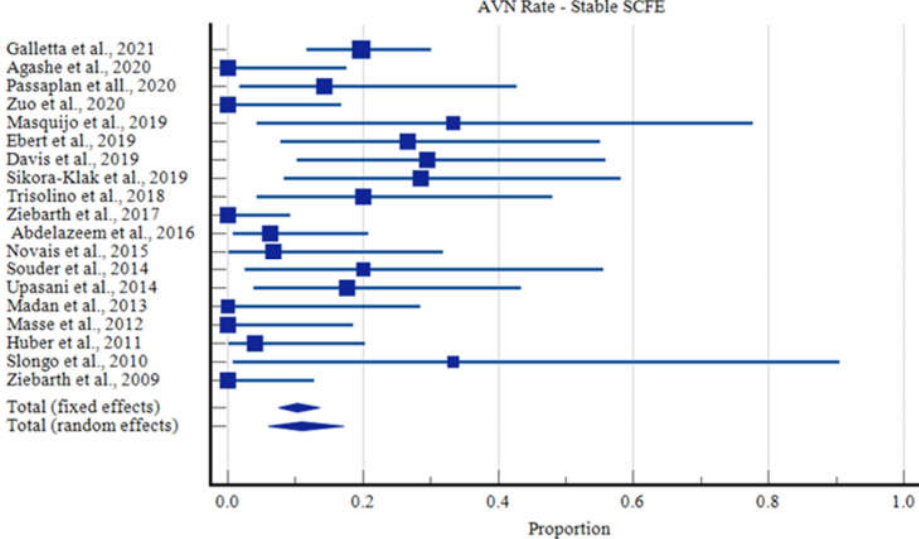
Figure 3. Rates of Avascular Necrosis in Stable SCFE Cases.